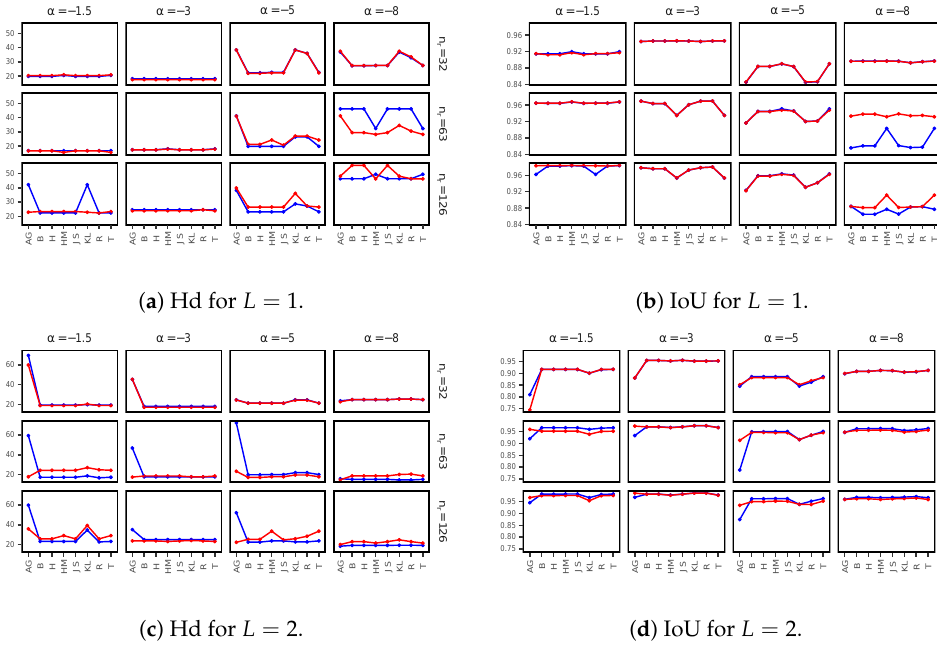
Figure 6. Hausdorff distance (Hd) and Intersection over Union (IoU) for simulated data. Blue and red points represent detected and “neat” points, respectively. Only one line is shown when these results coincide. Table 2. Cases in which it is recommended to use neat points for the B-spline